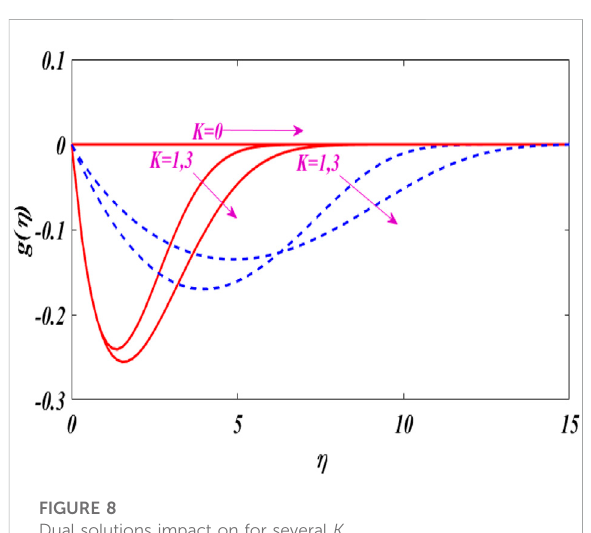
Dual solutions impact on for several K .